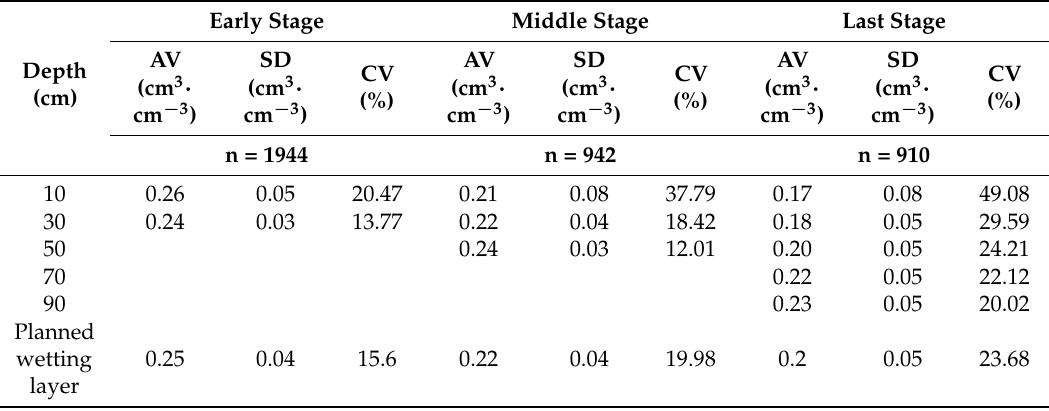
Table 4. Average value, standard deviation, and coefficient of variation of soil water content at different layers during the different growing stages of winter